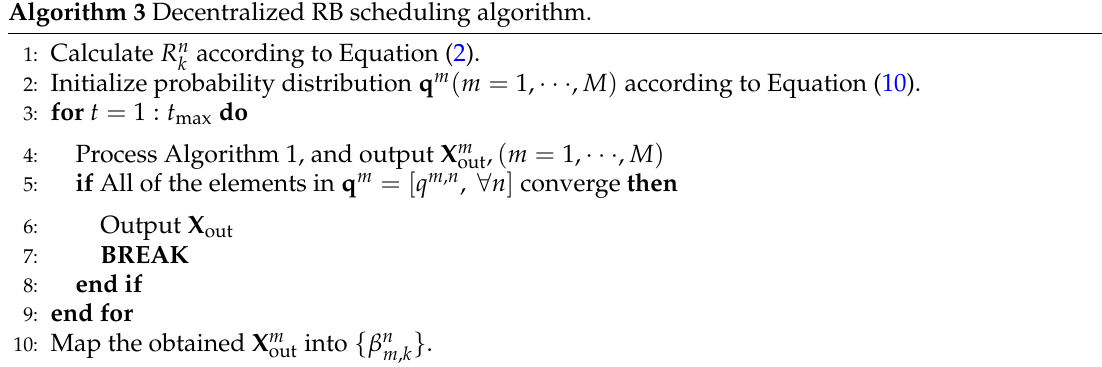
Algorithm 3 Decentralized RB scheduling